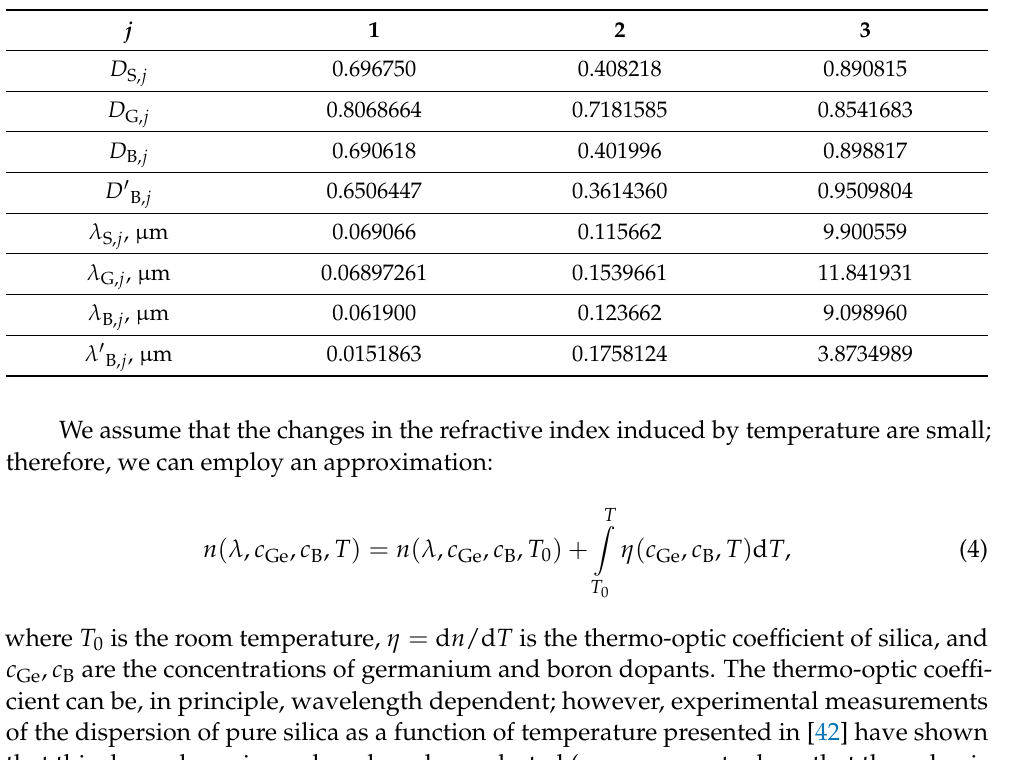
Table 3. Sellmeier’s coefficients for silica, germanium and